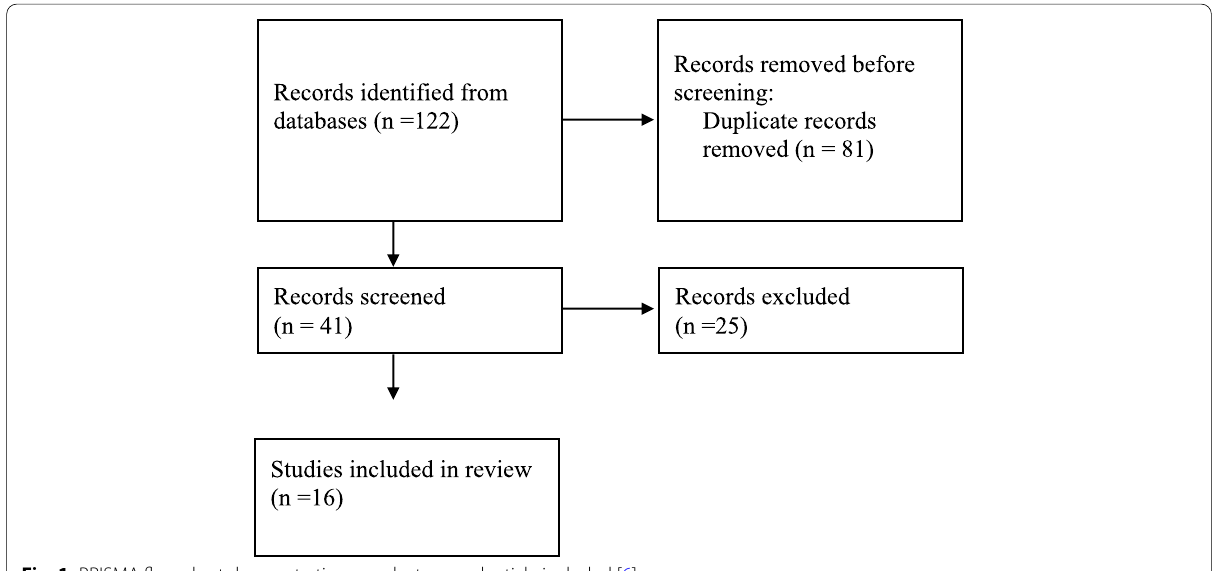
Fig. 1 PRISMA flow chart demonstrating search steps and article included